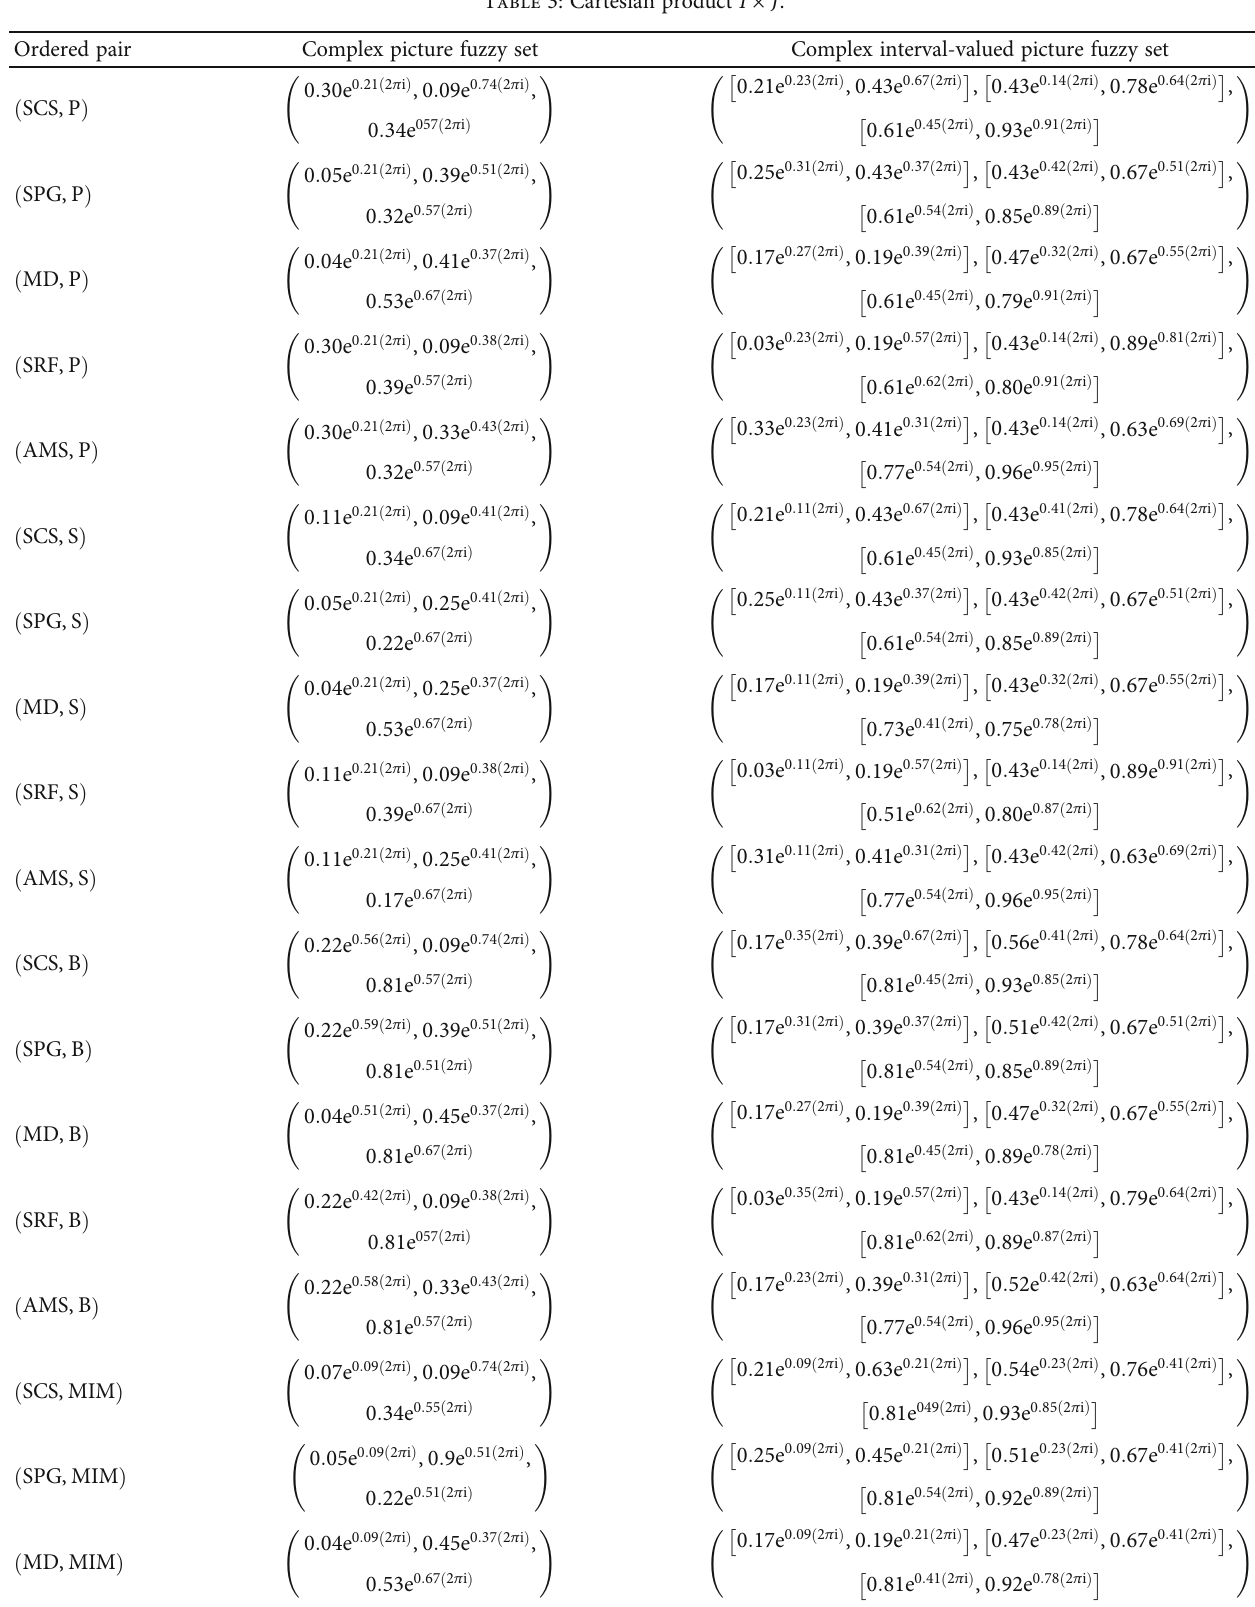
Table 3: Cartesian product I × J